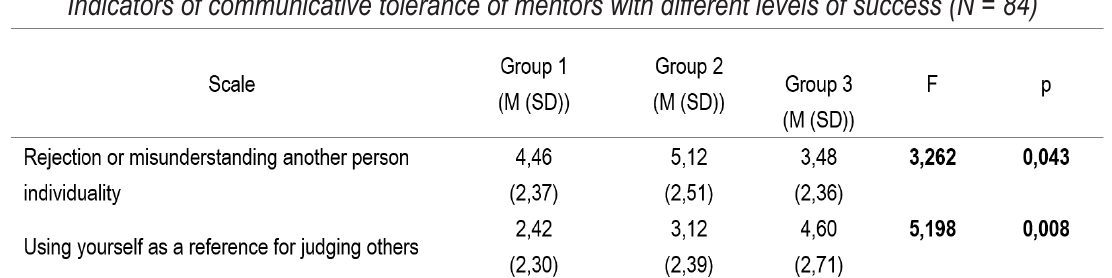
Indicators of communicative tolerance of mentors with different levels of success (N = 84)